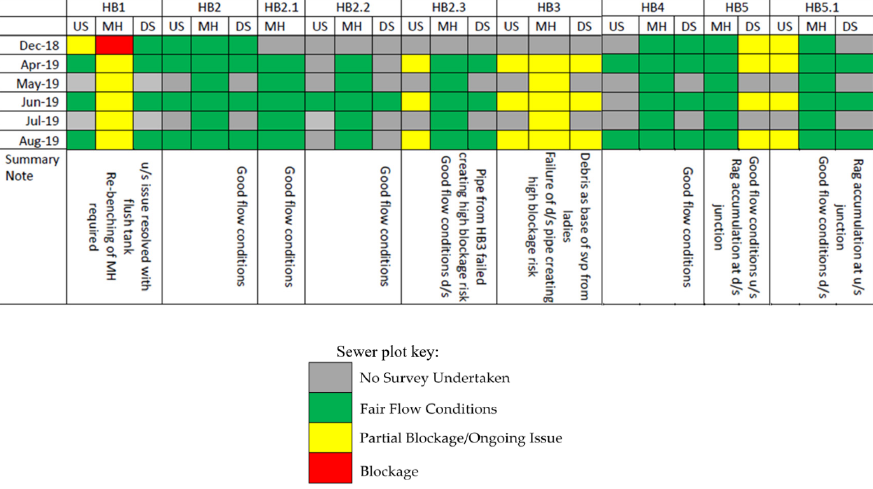
Figure 7. Example traffic light plot illustrating changes in sewer conditions at a series of nine manhole chambers outside the Harrison Building.